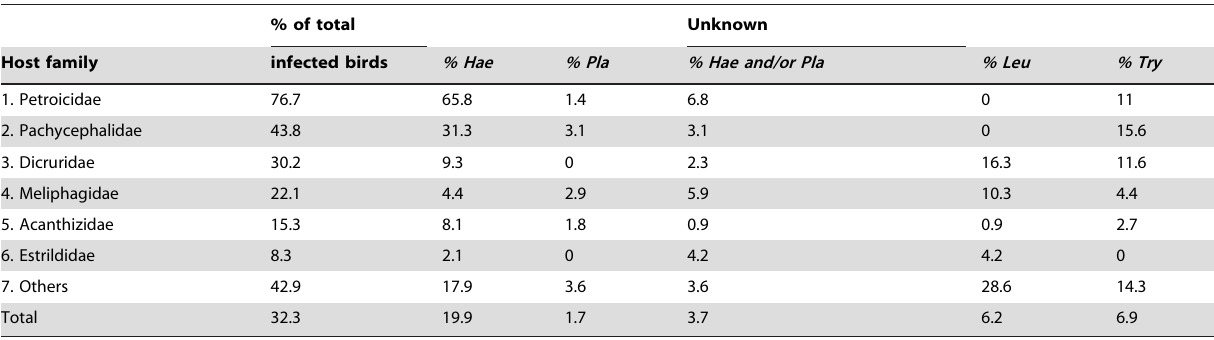
Table 2. Parasite prevalence across host